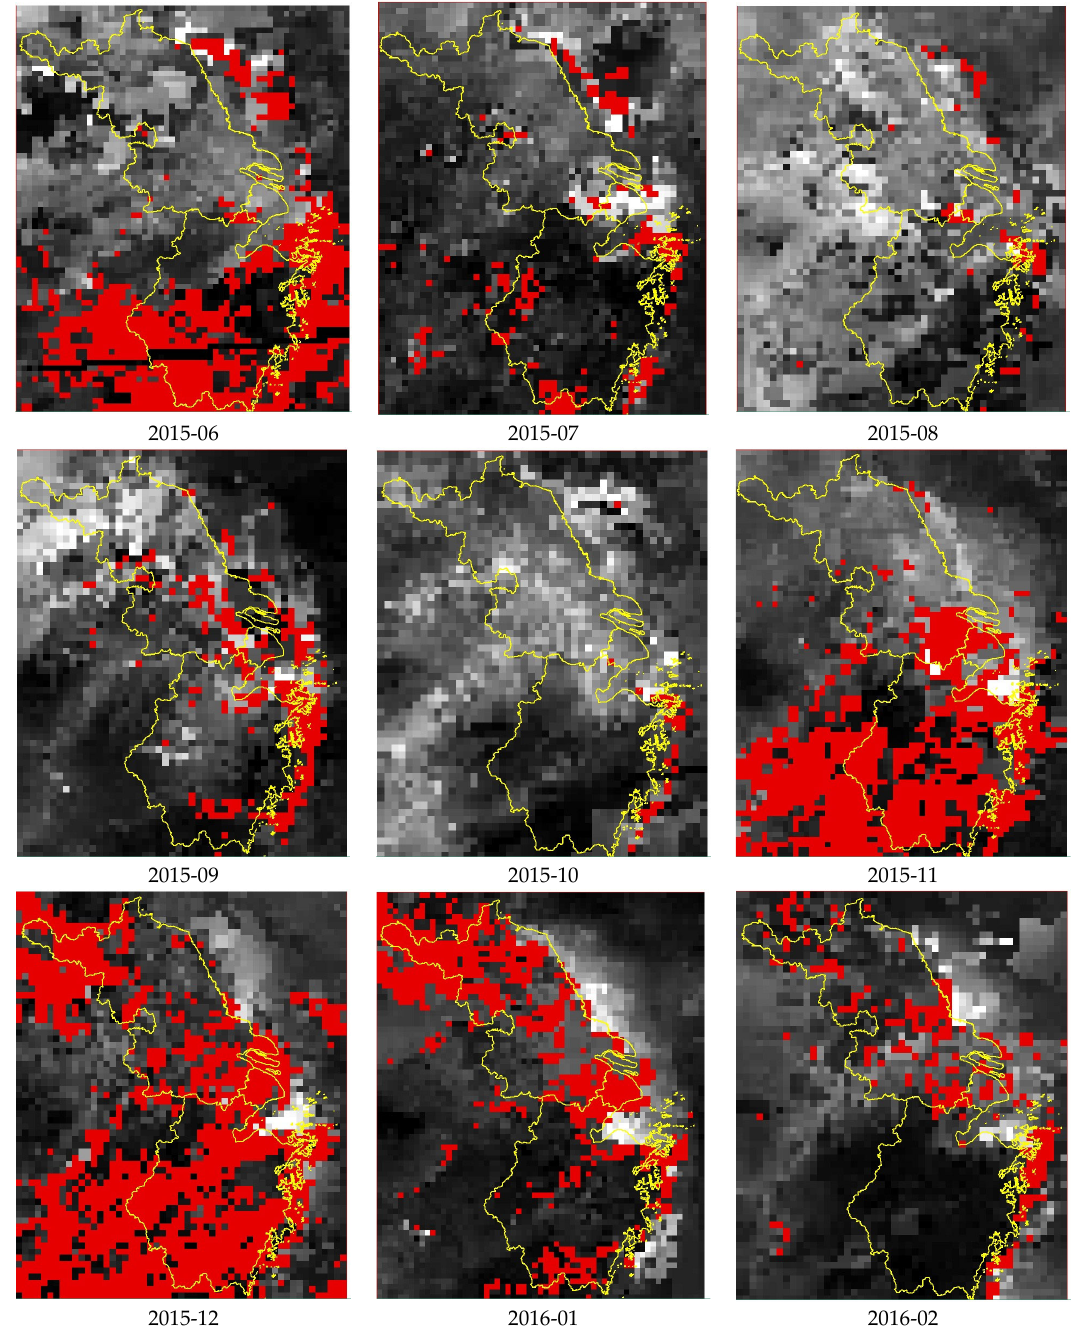
Figure 2. Monthly AOD data coverage in study area (2015/03–2016/02); the change in pixel color from black to white indicates the increasing value of AOD, and red pixels indicate missing value.